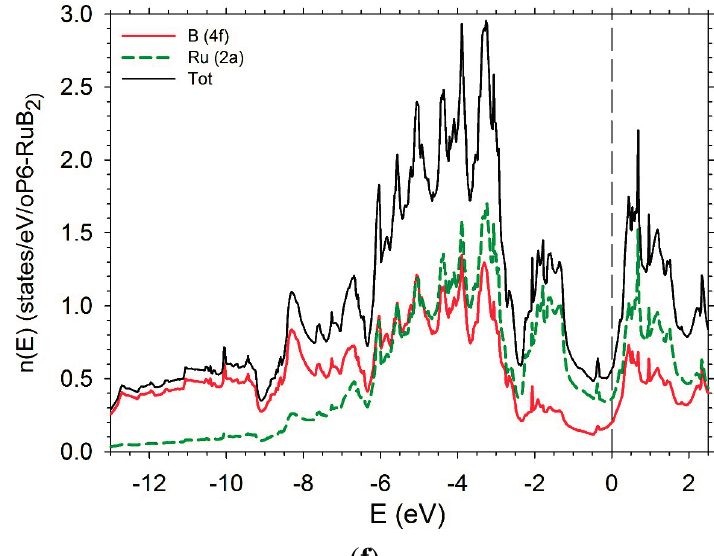
Figure 11. Electronic densities of states. ( a ) hP3-TiB 2 ; ( b ) tI12-TiB 2 ; ( c ) hR6-MoB 2 ; ( d ) hP12-WB 2 ; ( e ) hP6-ReB 2 ; ( f ) oP6-RuB 2